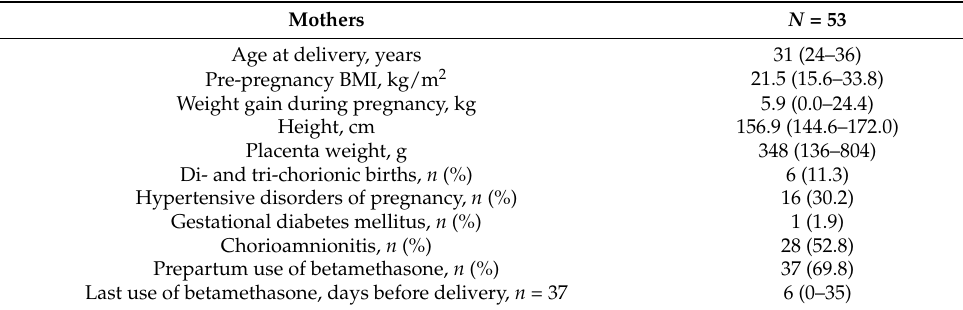
Table 1. Clinical characteristics of mothers and